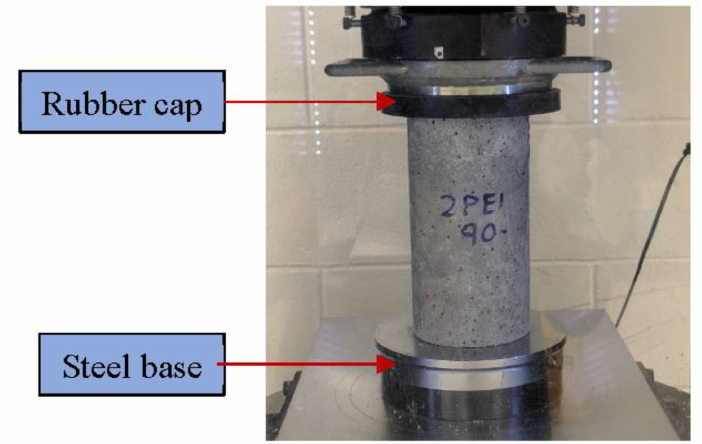
Figure 8. Compressive strength test setup of cylinder